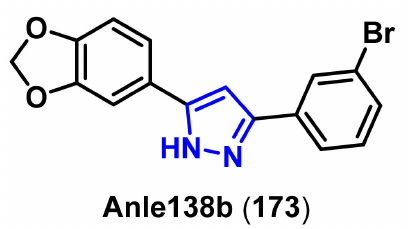
Figure 17. Chemical structure of a protein aggregation